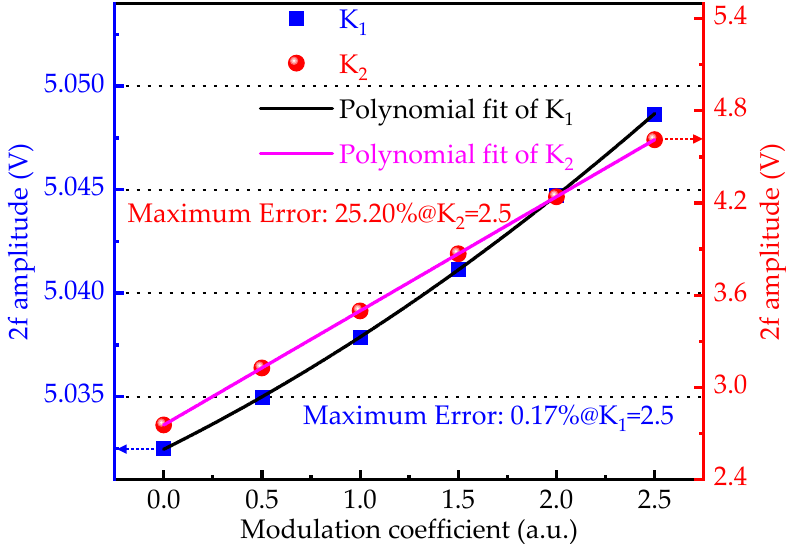
Figure 4. Influence of K 1 and K 2 change on the amplitude of 2f from the overlapping absorption lines.